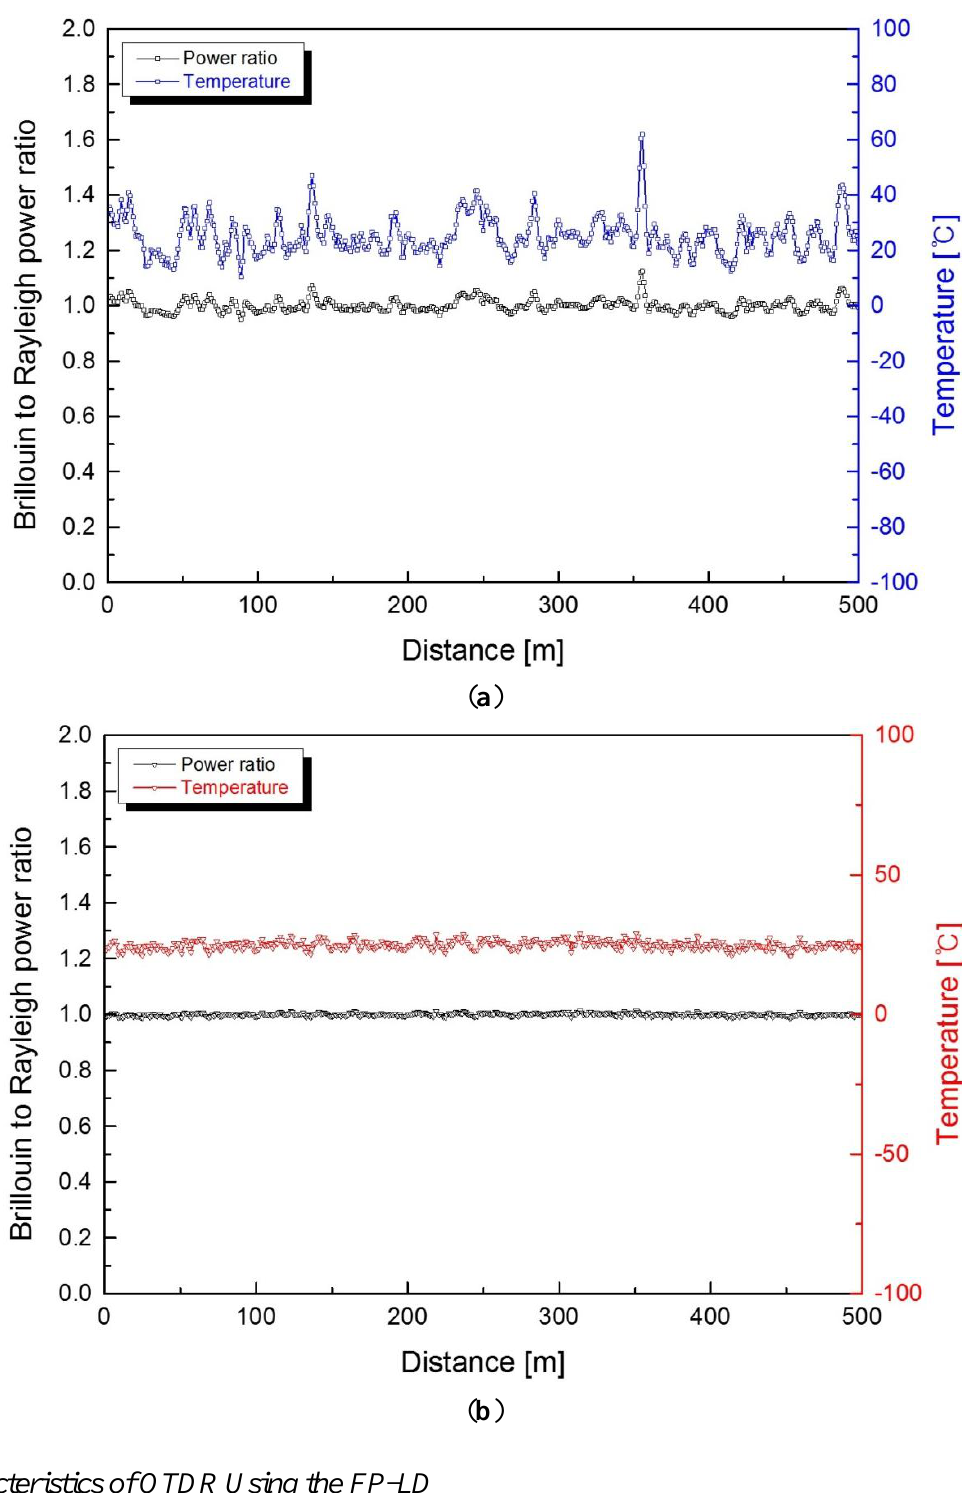
Figure 6. Measured Brillouin to Rayleigh power ratio and distributed temperature profiles for ( a ) the single-stage and ( b ) the dual-stage FBG